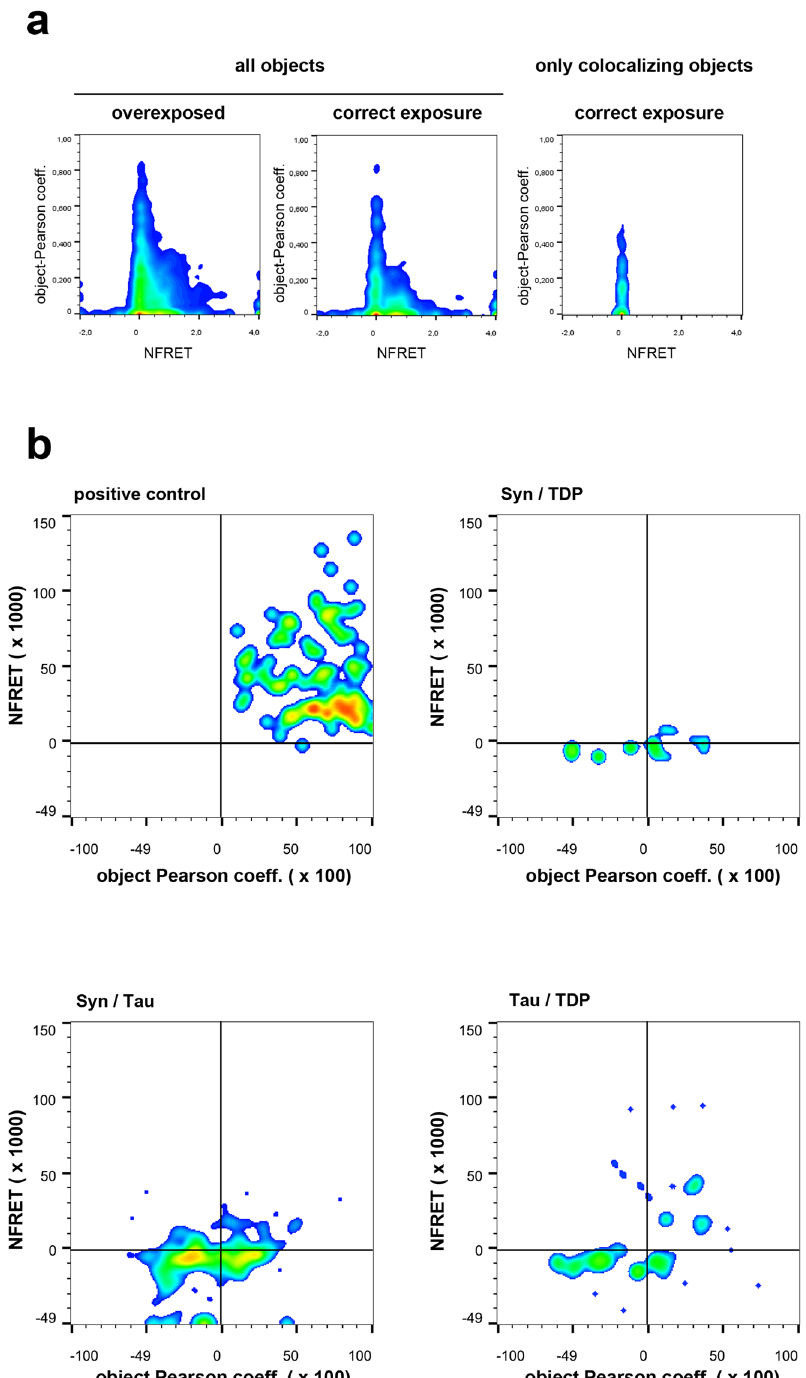
Figure 3. Combination of the novel colocalization analysis routine with FRET microscopy for the different neuropathologic stainings. ( a ) Visualization and analysis of FRET and colocalization with standard cytometry software ( FlowJo X . 0 . 7 ). Syn/Tau double stains were analyzed with our novel ImageJ macro and the results were further processed with MS-Excel 2013 ™ , saved as comma-separated values (csv)-files and imported to the cytometry software. Smoothed pseudocolored density plots are shown for normalized, correct FRET values (NFRET) versus the object-Pearson coefficient. The impact of overexposure as compared to correct exposure is shown and the effect of restricting the analysis to colocalizing objects is depicted as indicated. ( b ) Cytometric evaluation of the different neuropathologic stainings. The positive control (pTau/pTau) exhibits an object population with clear positive values for NFRET and object Pearson coefficient (upper right quadrant). Double- stainings of distinct neurodegeneration-related proteins (Syn/TDP; Syn/Tau and Tau/TDP) show NFRET values close to zero and Pearson coefficients varying around